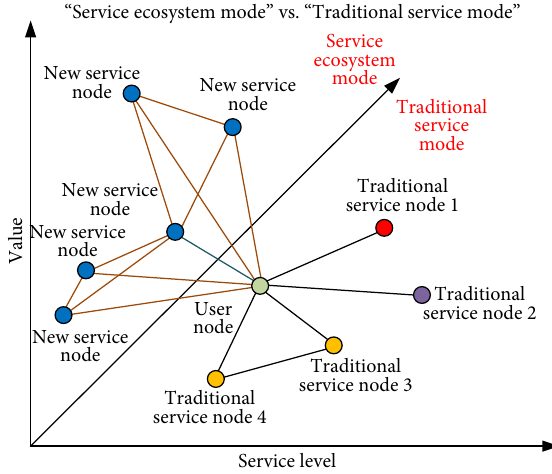
Fig. 13 Dimensionality reduction strikes of the service ecosystem.